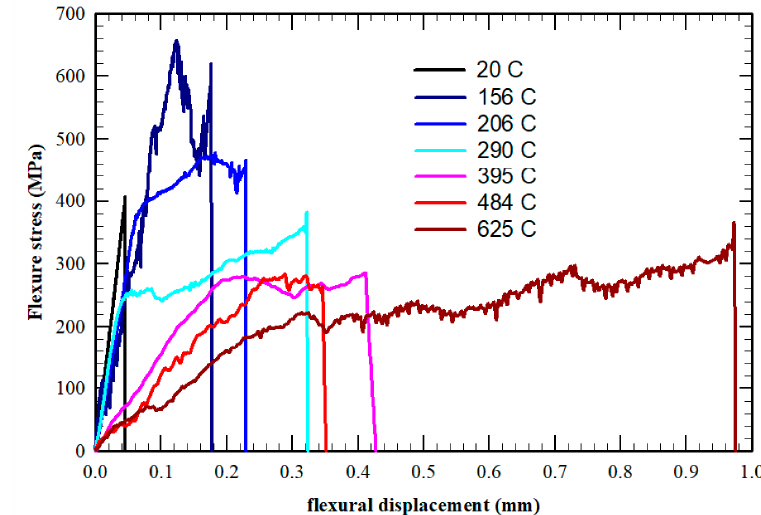
Figure 13. Three-point bending behavior at different temperatures for W-ZrC (0.5 wt.%) composites.